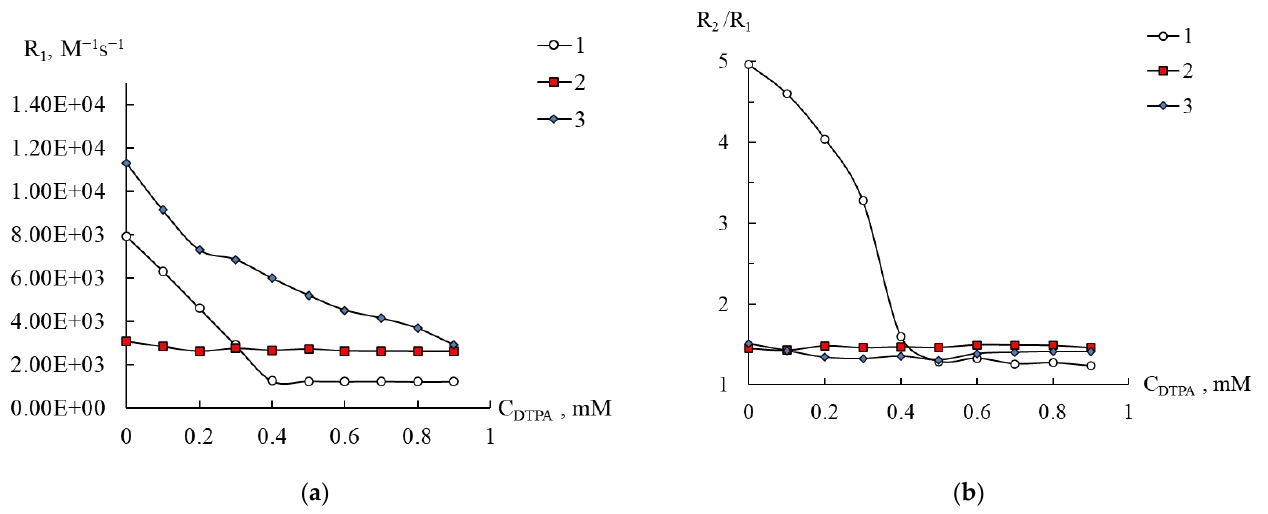
Figure 11. Dependence of the relaxation efficiency R1 ( a ) and the ratio R 2 /R 1 ( b ) on the concentration of DTPA in aqueous solutions of Mn(II) (1) and compounds 1 (2) and 3 (3). C Mn(II) 0.2 (3), 0.4 mM (1, 2), pH 5.5.